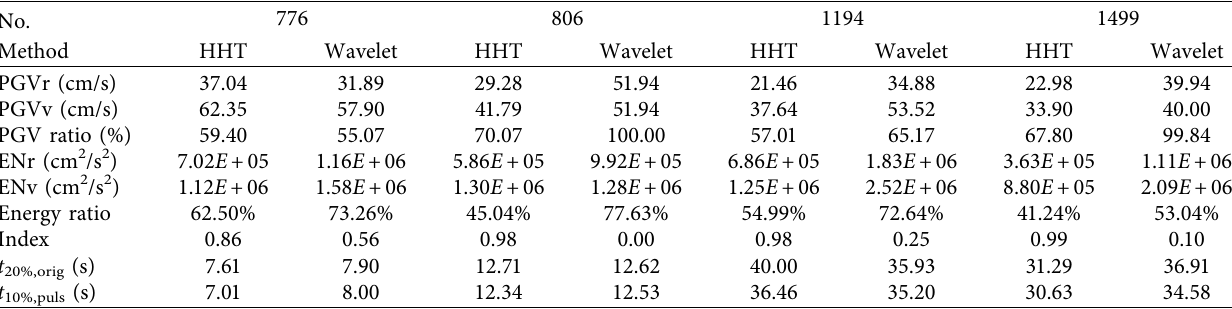
Figure 19: No. 1499 ground motion. (a) The extracted pulse based on HHT. (b) The extracted pulse based on wavelet. Table 3: The velocity pulse parameters.